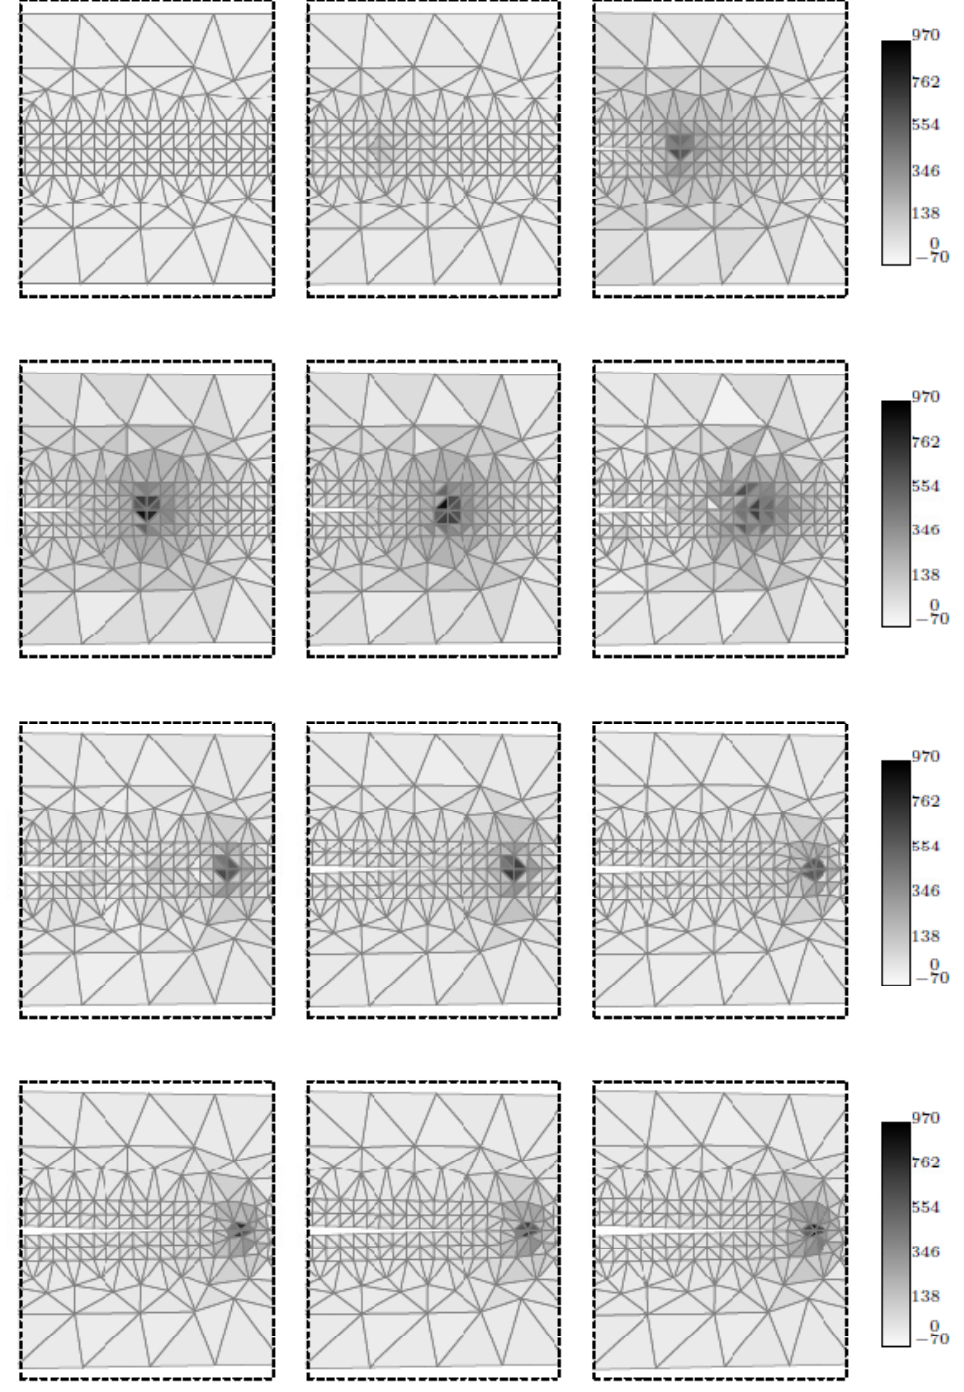
Figure 11: Evolution of the strip geometry and mesh for U=0.00, 0.005, 0.010, 0.015, 0.030, 0.035, 0.040, 0.045, 0.050, 0.055, 0.060, 0.065 (from left to right, from top to bottom). The maximum normal stress is reported in a grey